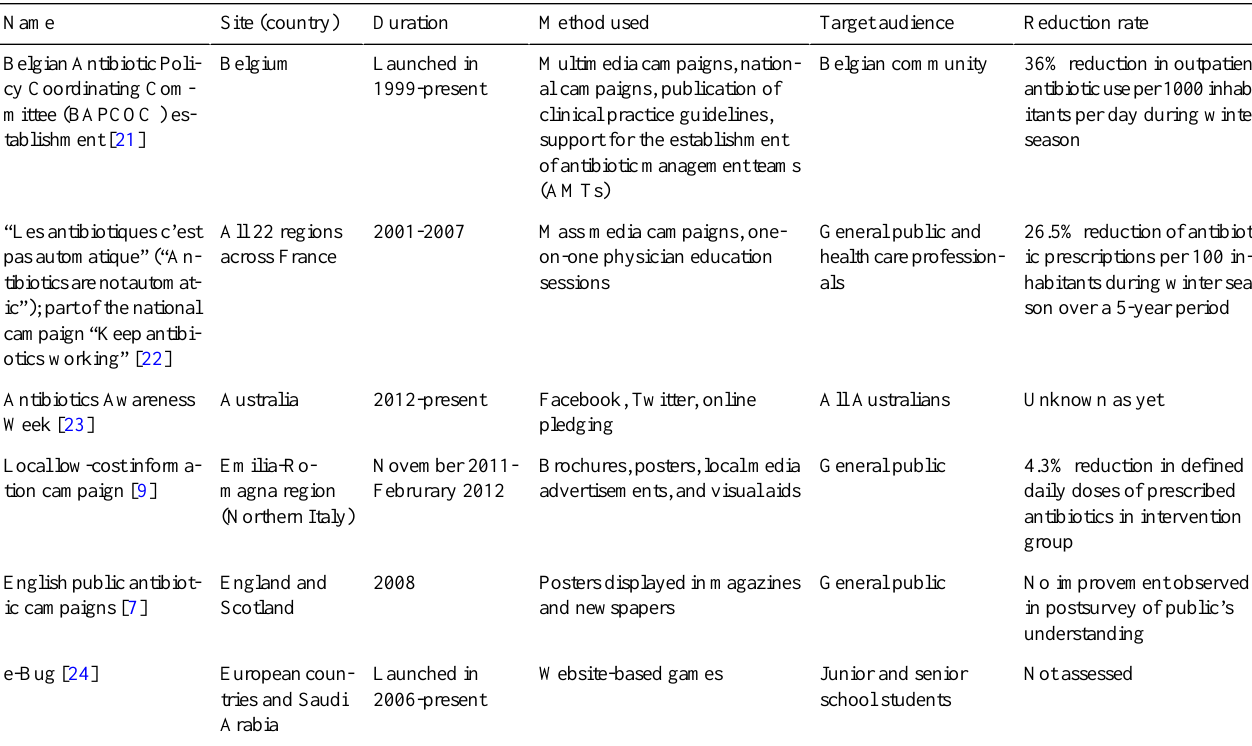
Table 1. Summary of selected antibiotic awareness campaigns worldwide.